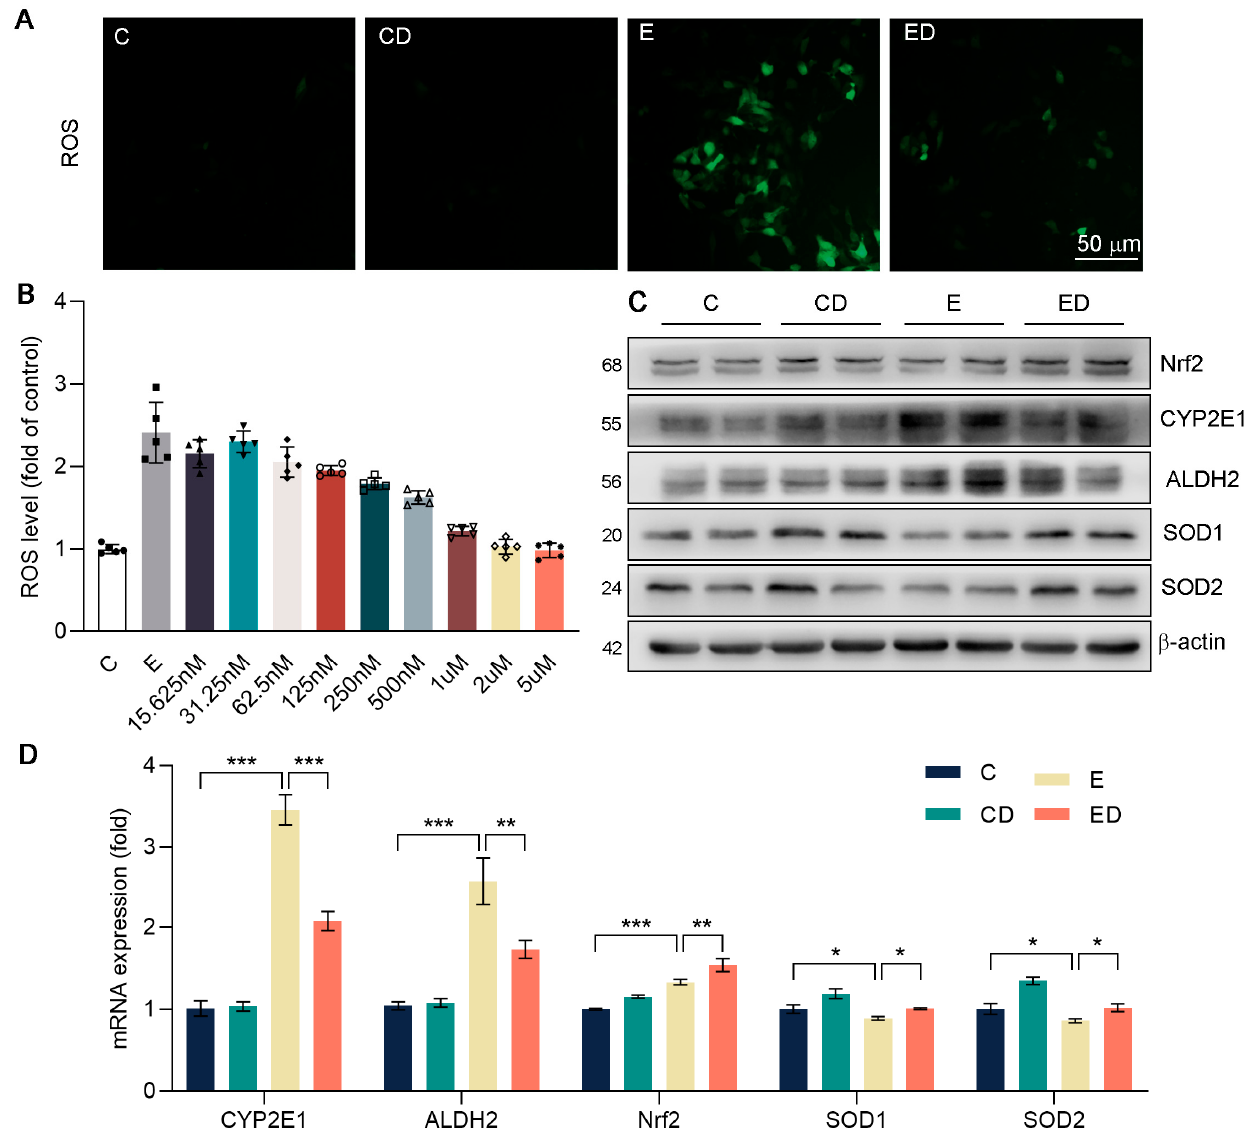
Figure 5. The effect of DAU on oxidative stress in HepG2 cells induced by alcohol. ( A ) DCFH − DA staining of HepG2. ( B ) ROS levels of HepG2. ( C ) Protein expression of Nrf2, CYP2E1, ALDH2, SOD1 and SOD2 in HepG2. ( D ) mRNA expression of Nrf2, CYP2E1, ALDH2, SOD1 and SOD2 in HepG2. Data are mean ± SD using one − way ANOVA ( n ≥ 3), * p < 0.05, ** p < 0.01, *** p <